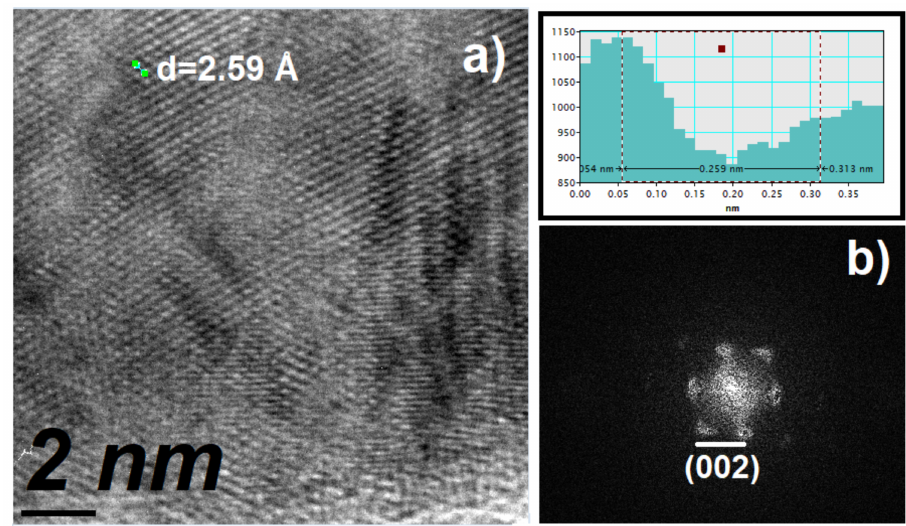
Figure 5. ( a ) TEM micrograph of the Zn-doped GaN films; ( b ) Electron diffraction pattern of the Zn-doped GaN films which demonstrated the GaN hexagonal structure.